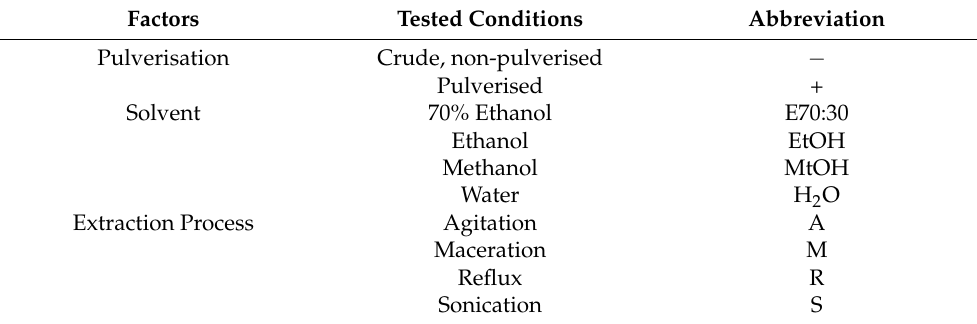
Table 2. Independent variables used in the Design of Experiments to optimise the extraction of bee pollen for antioxidant evaluation. Factors Tested Conditions Abbreviation Pulverisation Crude, non-pulverised